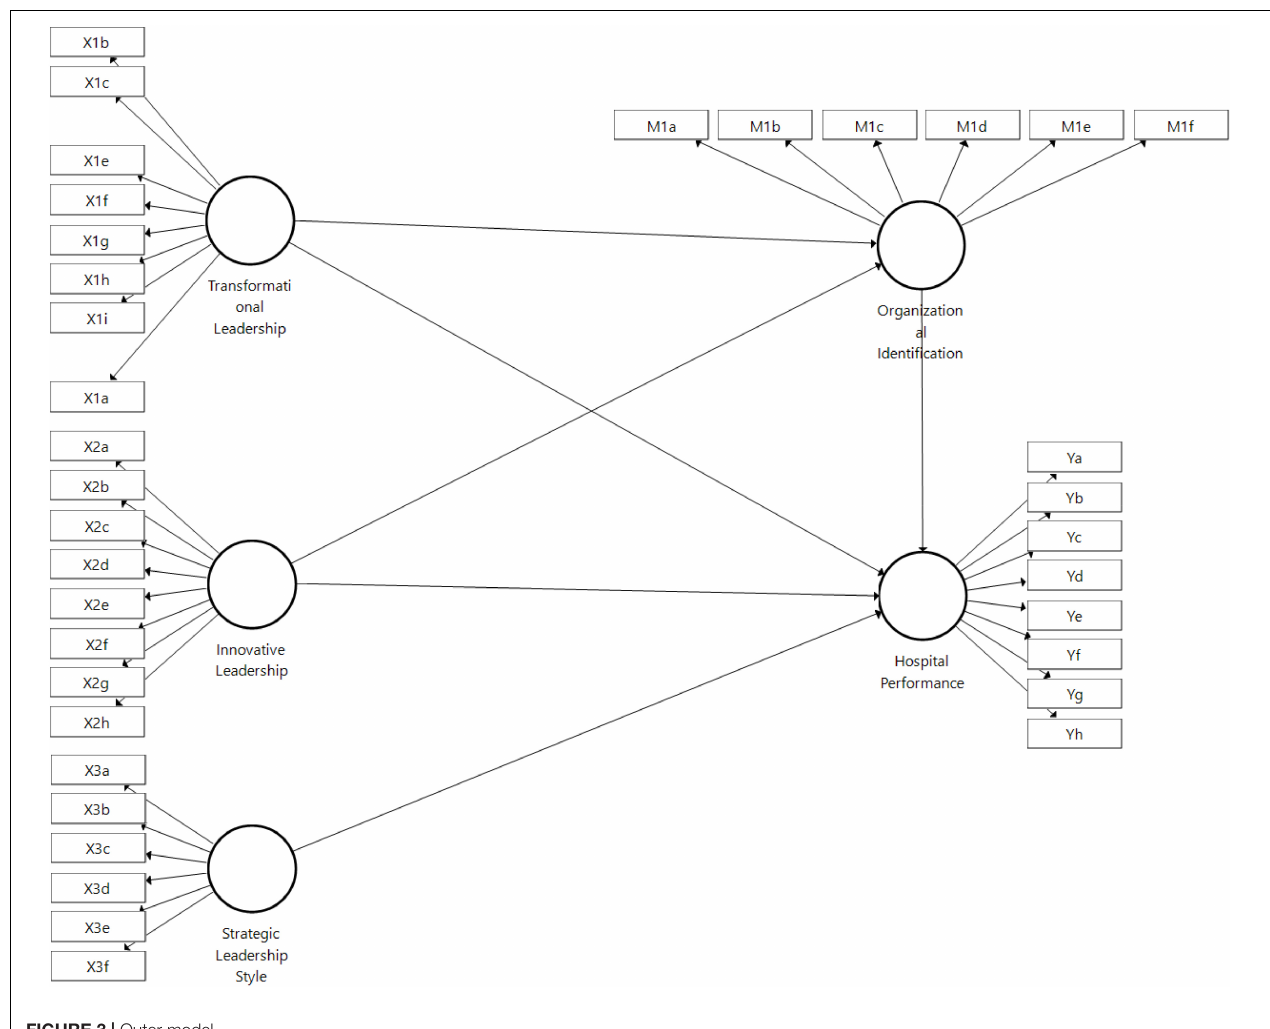
FIGURE 3 | Outer model. TABLE 3 | Fornell-Larcker